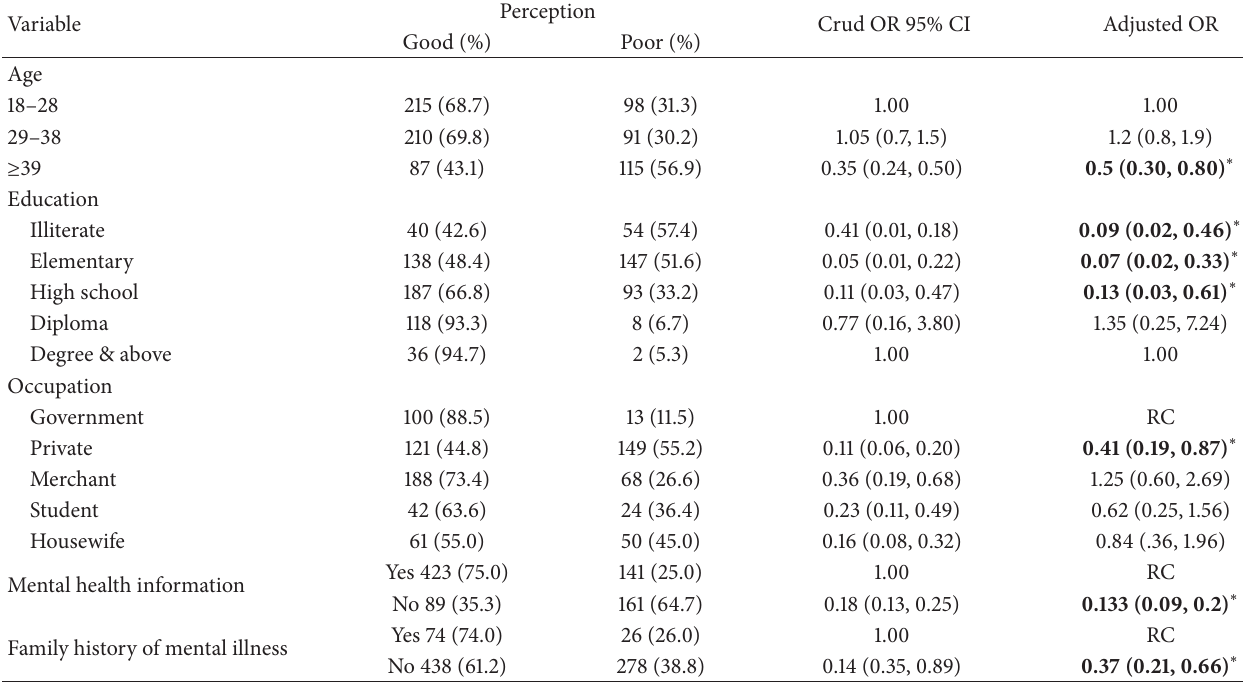
Table 5: Distribution of factors associated with community’s perception of mental illness among residents of Gimbi town, West Wellega Zone, Oromia region, Ethiopia,